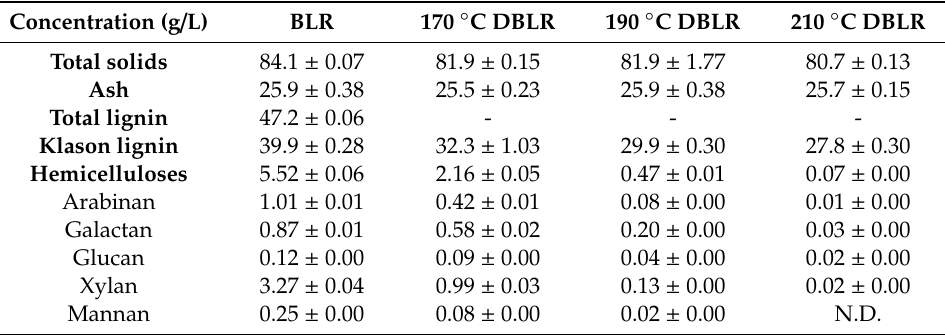
Table 2. Characteristics of BLR before and after